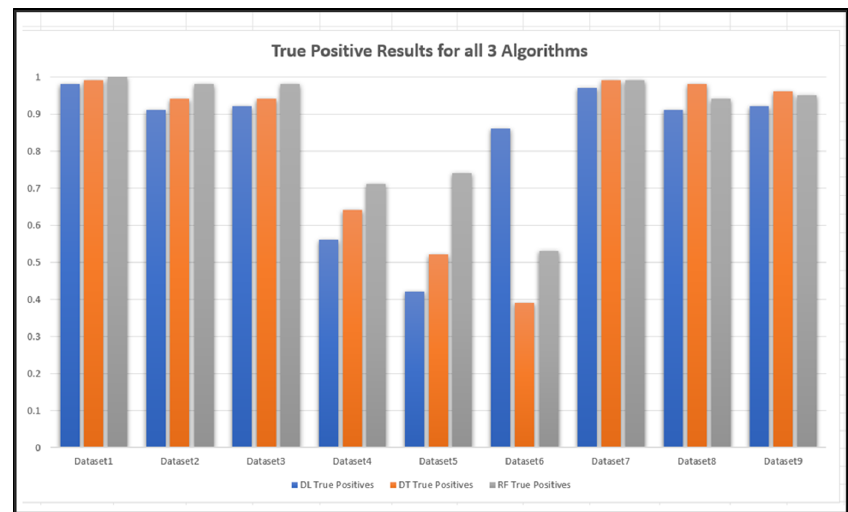
Figure 5. Comparison of the Zeus prediction results for all three ML algorithms.